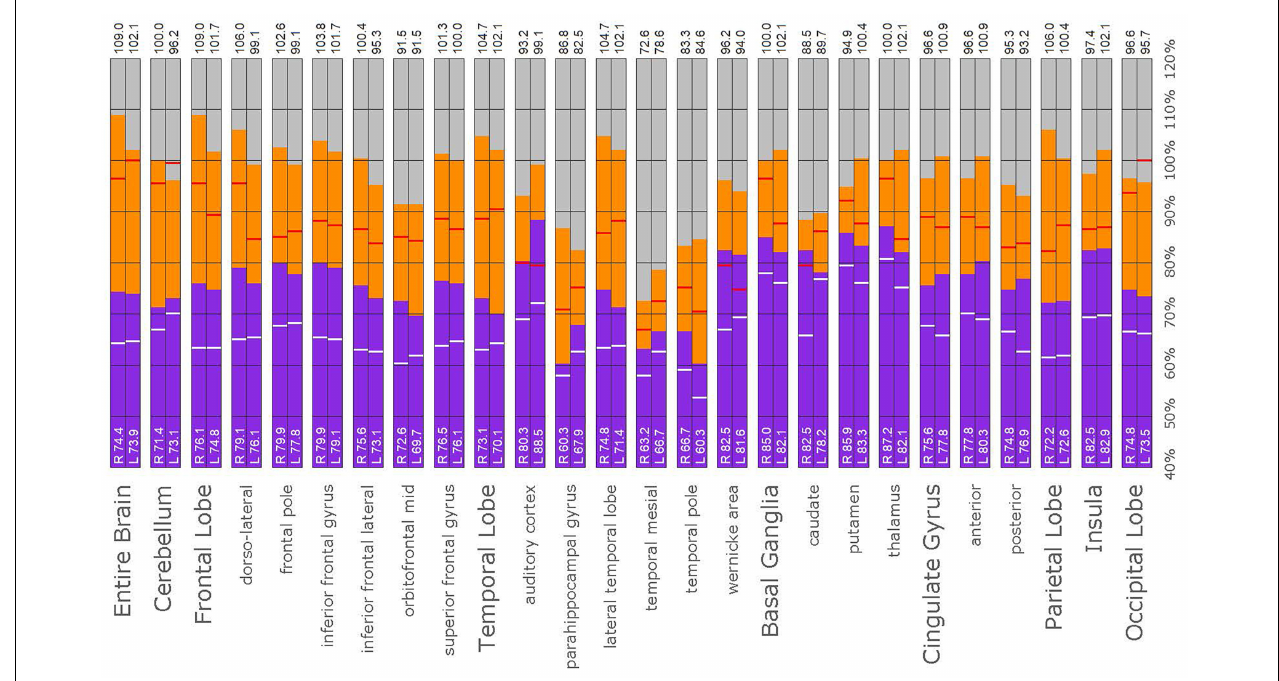
FIGURE 12 | Semi-quantitative region of interest analysis of the SPECT scan of Patient C. Data analysis and presentation is as described in Figure 10 . Thalamic perfusion is asymmetrical and exceeds that of the cerebellar maximum. Multiple cortical areas show increased perfusion which exceeds the cerebellar maximum and the comparable maximal value of the normative sample. Asymmetric perfusion is seen in most cortical areas. In all ROI, with the exception of the cerebellum and left occipital lobe, the patient’s maximal counts exceed that of the normative sample (red line). In all ROIs, the patient’s median counts exceed that of the normative sample (white